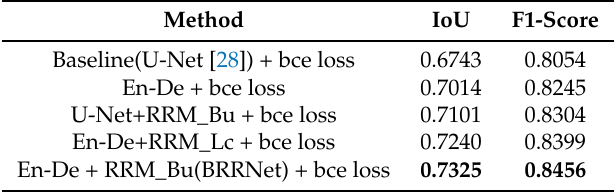
Table 1. Experimental results of different network structures.